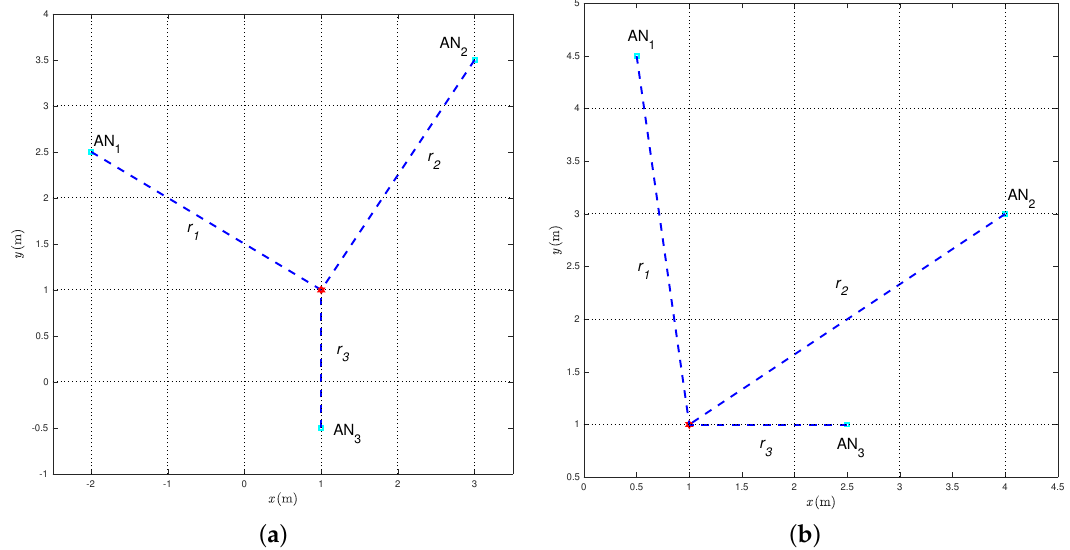
Figure 5. Considered geometrical scenarios: ( a ) “good” and ( b ) “bad.” In both cases, the true position of the TN (red star) is shown, together with the positions of three ANs (blue stars). The distances { r } 3 are also i i = 1